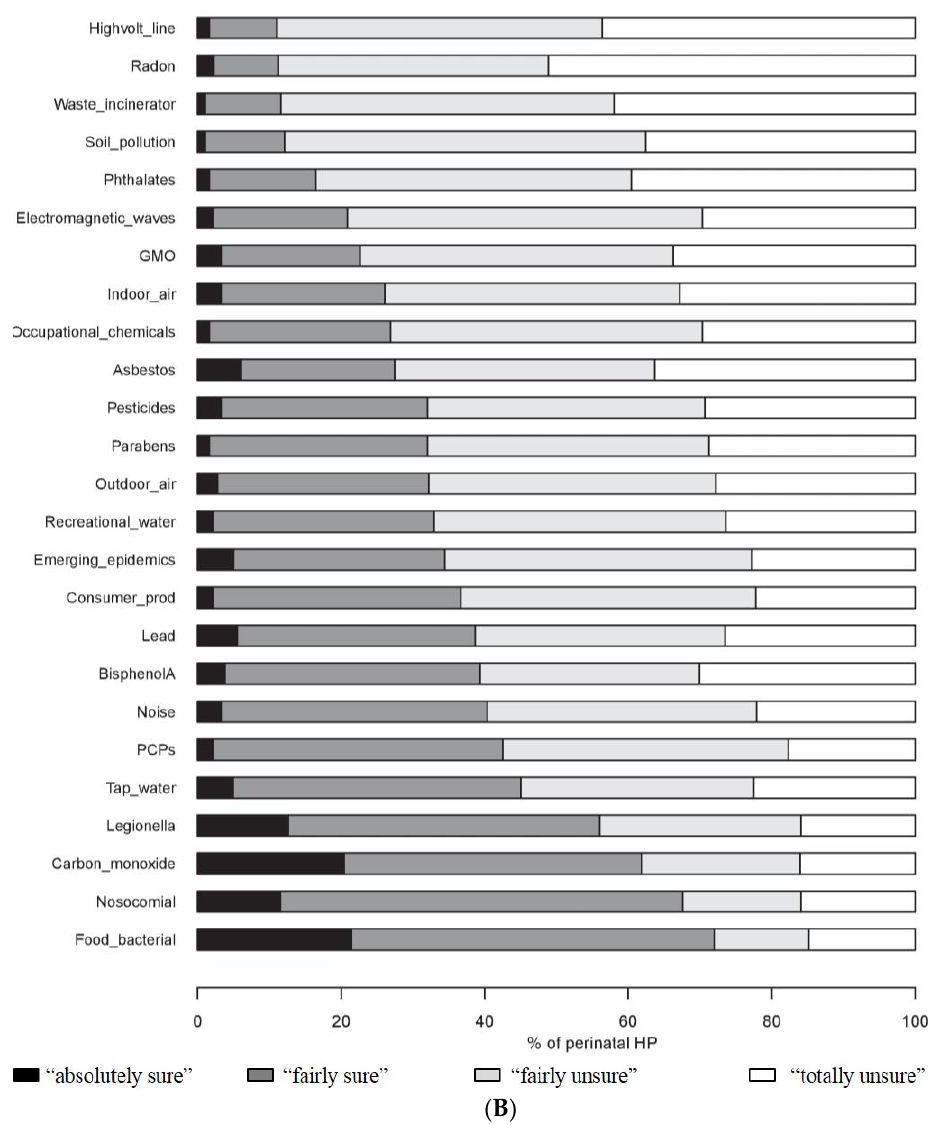
Figure 3. Enquiries made to perinatal HPs by pregnant women about environmental issues ( A ); and ability of perinatal HPs to provide appropriate answers ( B ). Consumer_prod, consumer products (corresponds to household, DIY and gardening products); GMO, genetically modified organism; HP, health professionals; PCPs, personal care products.